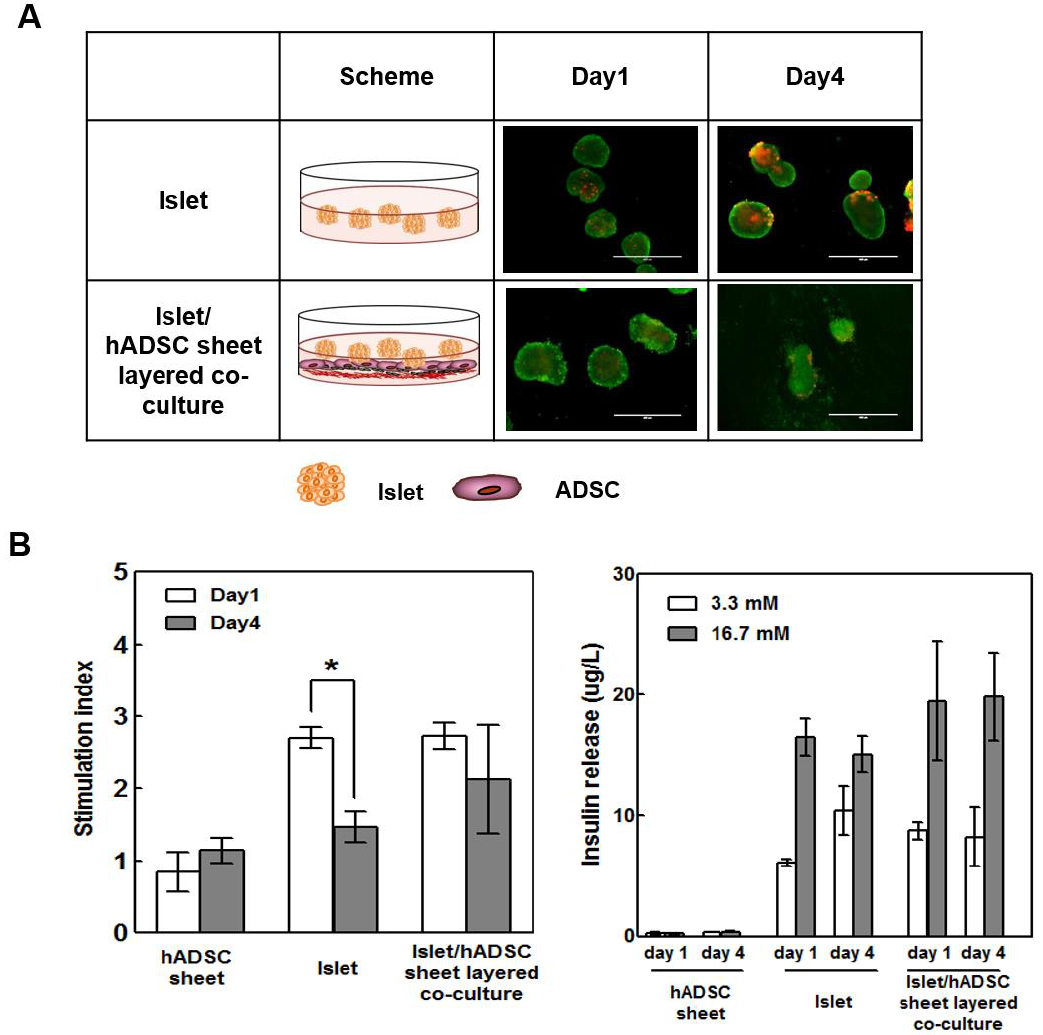
Figure 2. AI sheet groups showed better viability and glucose response than the islet-only group during the culture period. ( A ) The viability of islets and AI sheets was assessed by LIVE / DEAD staining. ( B ) Insulin release at 3.3 mM and 16.7 mM glucose in the hADSC sheet, islets, and AI sheet (in triplicate). The glucose-stimulated insulin secretion (GSIS) test showed better glucose response by the AI sheet group than by the islet-only group on days 1 and 4. Hundred hand-picked rat islets were used for each well. Results are presented as mean ± SD. Statistical significance was determined by a t-test of the stimulation index on days 1 and 4; * p < 0.05, n = 5.